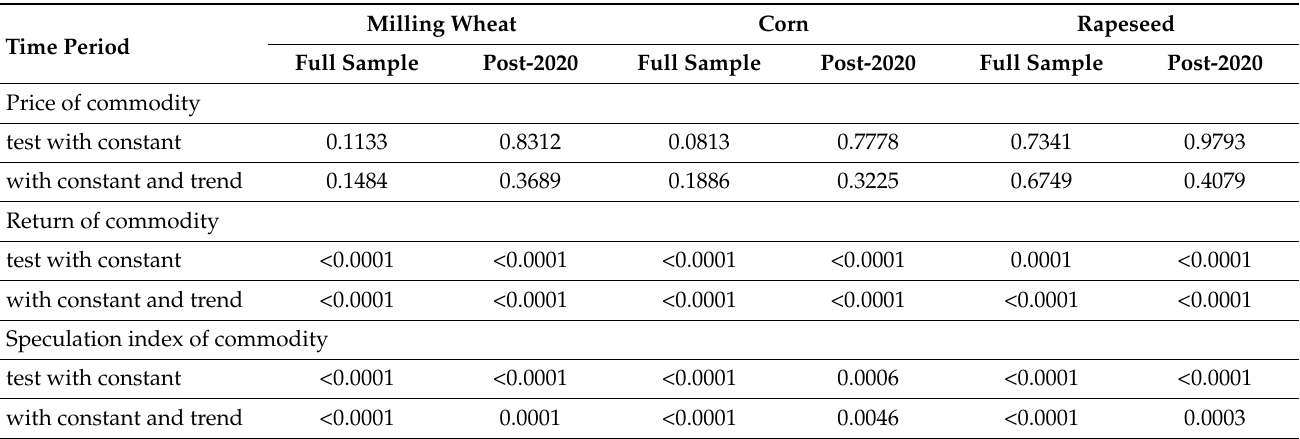
Table 2. Augmented Dickey–Fuller test results.